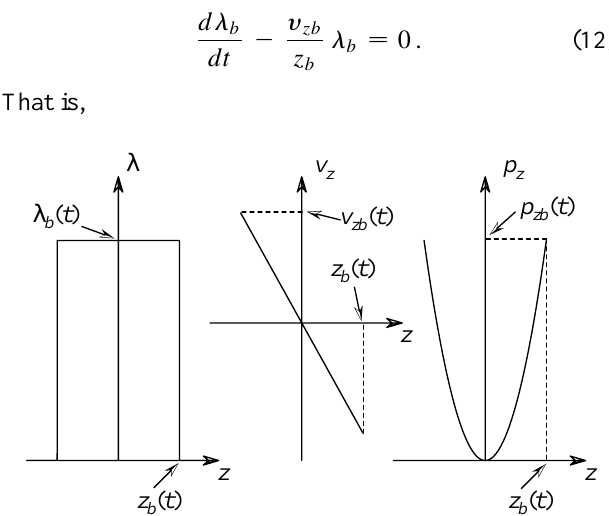
FIG. 1. The z dependences of field variables for the linear self- similar drift compression